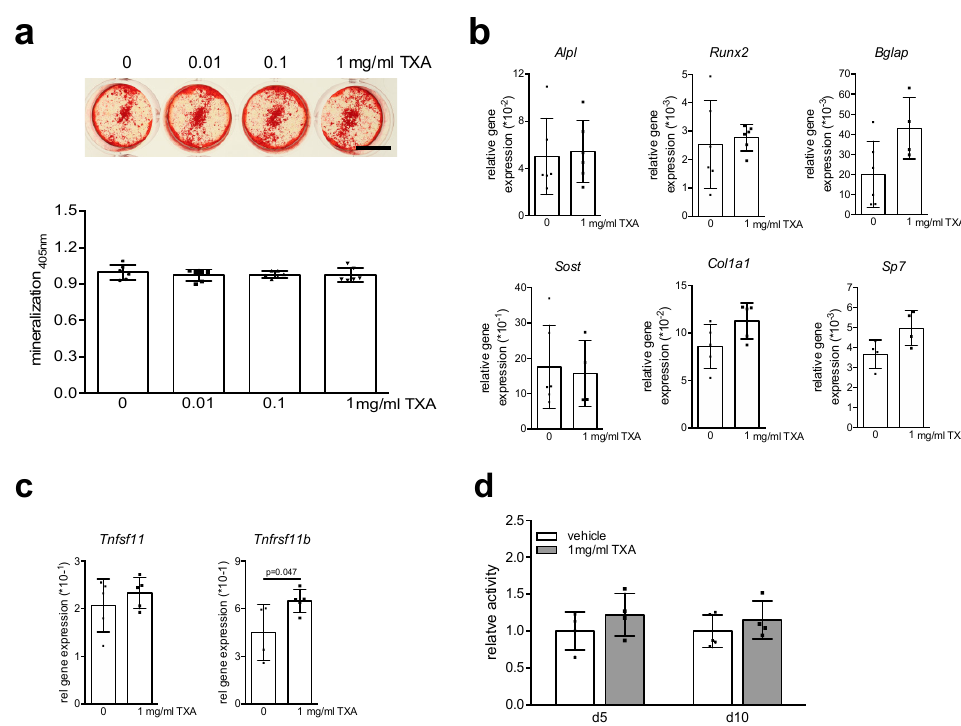
Figure 1. TXA does not affect the differentiation or function of calvaria-derived osteoblasts. ( a ) Representative alizarin red stainings of calvaria-derived osteoblasts from WT mice differentiated in the presence of indicated concentrations of TXA for 10 days in osteogenic medium. Scale bar 10 mm. The quantification of extracellular matrix mineralization is indicated below. ( b ) qRT-PCR expression analysis for the indicated genes in calvaria-derived osteoblasts at day 10 of osteogenic differentiation, stimulated with TXA (1 mg/mL) during the entire course of cell differentiation. ( c ) qRT-PCR expression analysis for the indicated genes in the same samples. ( d ) MTT proliferation assay of calvaria-derived osteoblasts stimulated with 1 mg/mL TXA for 6 h at the indicated days of differentiation. For ( a – d ), n = 4–6 independent cultures per group were used, as indicated by individual data points. Data presented are means ± SD. Gene abbreviations: runt-related transcription factor 2 ( Runx2 ), osterix ( Sp7 ), alkaline phosphatase ( Alpl ), alpha-1 type I collagen ( Col1a1 ), osteocalcin ( Bglap ), sclerostin ( Sost ), Rankl ( Tnfsf11 ), osteoprotegerin ( Tnfrsf11b ).